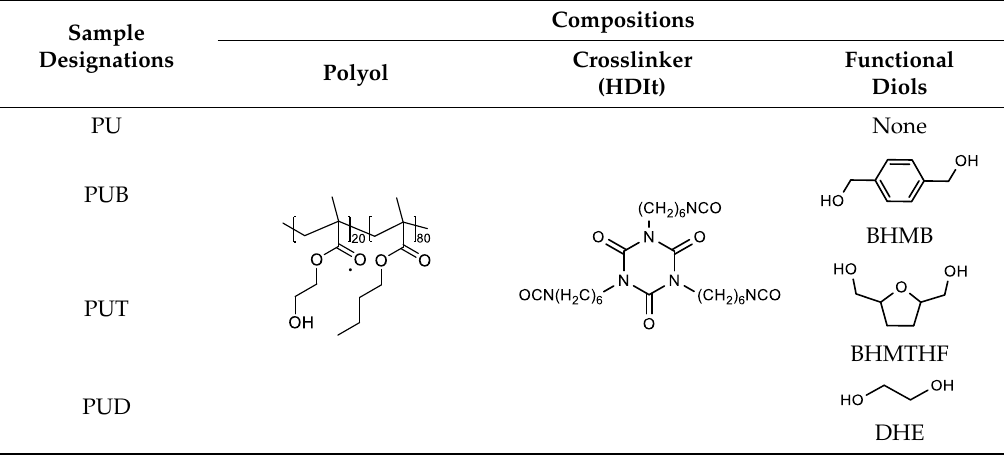
DHE Table 2. Optical properties (transmittance ( T r ), yellow index (YI), and haze), thermal property (glass Table 2. Optical properties (transmittance ( T r ), yellow index (YI), and haze), thermal property (glass transition temperature ( T g )), and thicknesses of conventional polyurethane (PU), PU with aromatic transition temperature ( T g )), and thicknesses of conventional polyurethane (PU), PU with aromatic Table 2. Optical properties (transmittance ( T r ), yellow index (YI), and haze), thermal property (glass moiety (PUB), PU with heterocyclic moiety (PUT), and PU with aliphatic moiety (PUD). All of the data Table 2. Optical properties (transmittance ( T r ), yellow index (YI), and haze), thermal property (glass Table 2. Optical properties (transmittance ( T r ), yellow index (YI), and haze), thermal property (glass moiety (PUB), PU with heterocyclic moiety (PUT), and PU with aliphatic moiety (PUD). All of the transition temperature ( T g )), and thicknesses of conventional polyurethane (PU), PU with aromatic Table 2. Optical properties (transmittance ( T r ), yellow index (YI), and haze), thermal property (glass points were obtained by averaging the results of three transition temperature ( T g )), and thicknesses of conventional polyurethane (PU), PU with aromatic transition temperature ( T g )), and thicknesses of conventional polyurethane (PU), PU with aromatic data points were obtained by averaging the results of three measurements. moiety (PUB), PU with heterocyclic moiety (PUT), and PU with aliphatic moiety (PUD). All of the transition temperature ( T g )), and thicknesses of conventional polyurethane (PU), PU with aromatic moiety (PUB), PU with heterocyclic moiety (PUT), and PU with aliphatic moiety (PUD). All of the moiety (PUB), PU with heterocyclic moiety (PUT), and PU with aliphatic moiety (PUD). All of the data points were obtained by averaging the results of three measurements. moiety (PUB), PU with heterocyclic moiety (PUT), and PU with aliphatic moiety (PUD). All of the data points were obtained by averaging the results of three measurements. data points were obtained by averaging the results of three measurements. data points were obtained by averaging the results of three measurements.